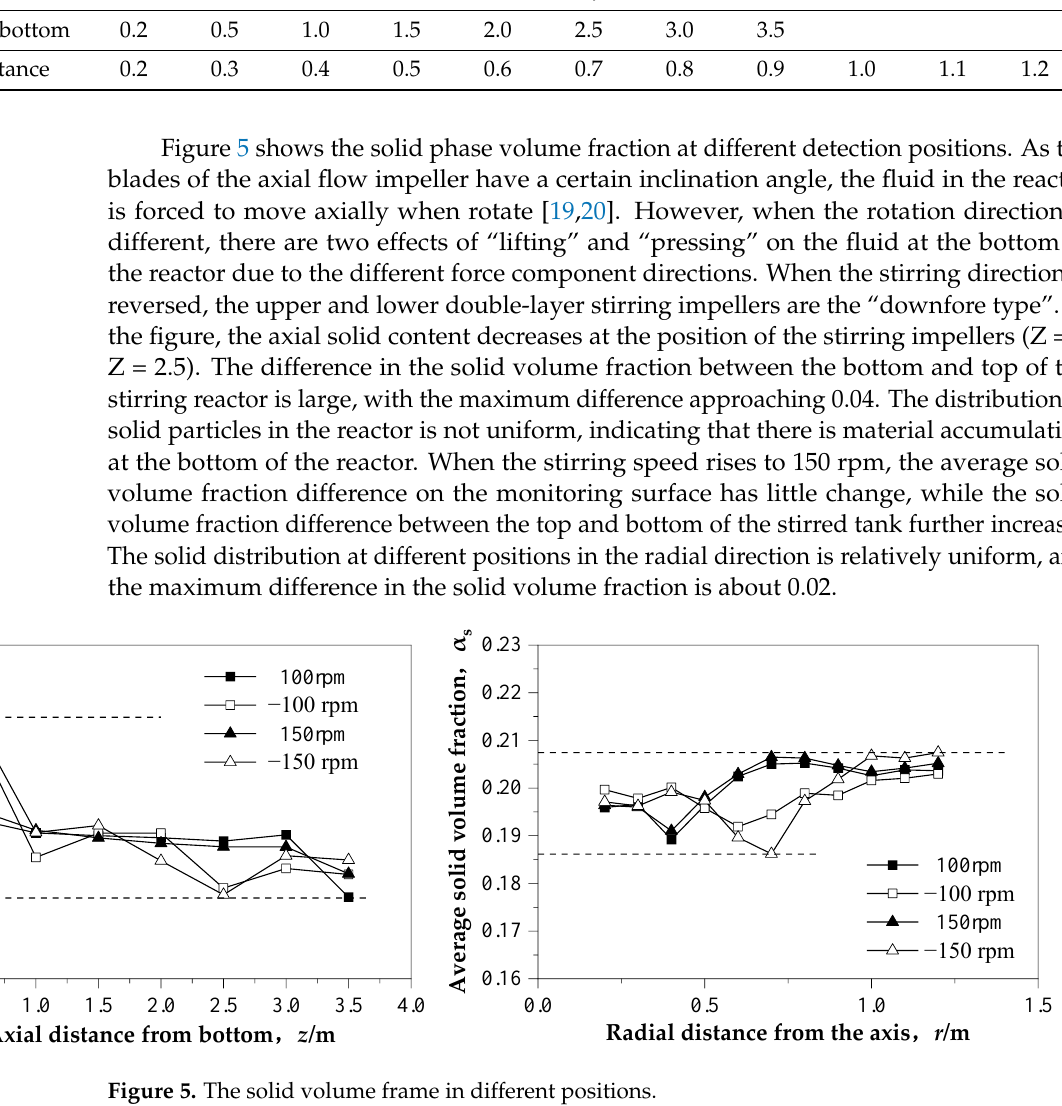
whole body is uniform at different positions in the radial direction, and the maximum difference of the solid volume fraction is about 0.015. As shown in Figure 6, different stirring directions have significant effects on gas-liq- uid dispersion. When the stirring shaft rotates in the opposite direction, there is better gas dispersion. Under forward stirring, the gas is more concentrated near the stirring shaft. Regardless of forward or reverse rotation, the dispersion of gas is both better at a stirring speed of 150 rpm than that at 100 rpm. Considering the energy consumption, the speed taken in the later research is 125 rpm. ( a ) 100 rpm ( d ) −150 rpm Figure 6. Gas distribution under different stirring speeds.